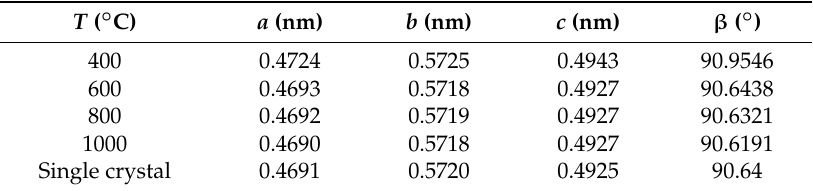
Figure 3. Rietveld analysis of the XRD curves of Eu-doped ZnWO 4 precursors subjected to annealing at different temperatures: ( a ) 400 ◦ C, ( b ) 600 ◦ C, ( c ) 800 ◦ C, and ( d ) 1000 ◦ C. Open circles: raw data. Solid green lines: Rietveld diffractograms. Table 1. Lattice parameters of Eu-doped ZnWO 4 derived from whole spectrum fitting and Rietveld refinement. Lattice parameters of ZnWO 4 single crystals are listed in the last row for comparison.